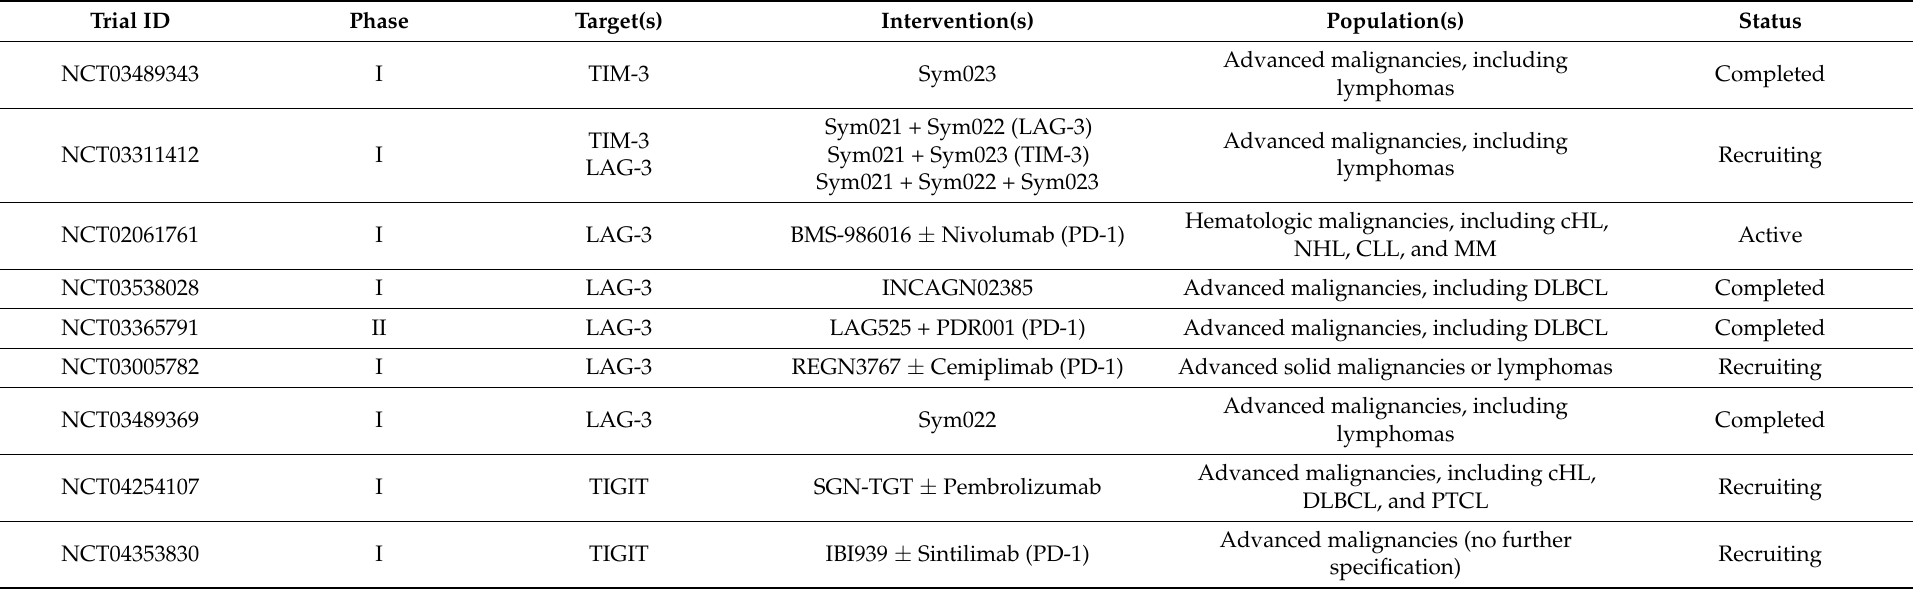
Table 5. Listed trials of investigational checkpoint inhibitors in